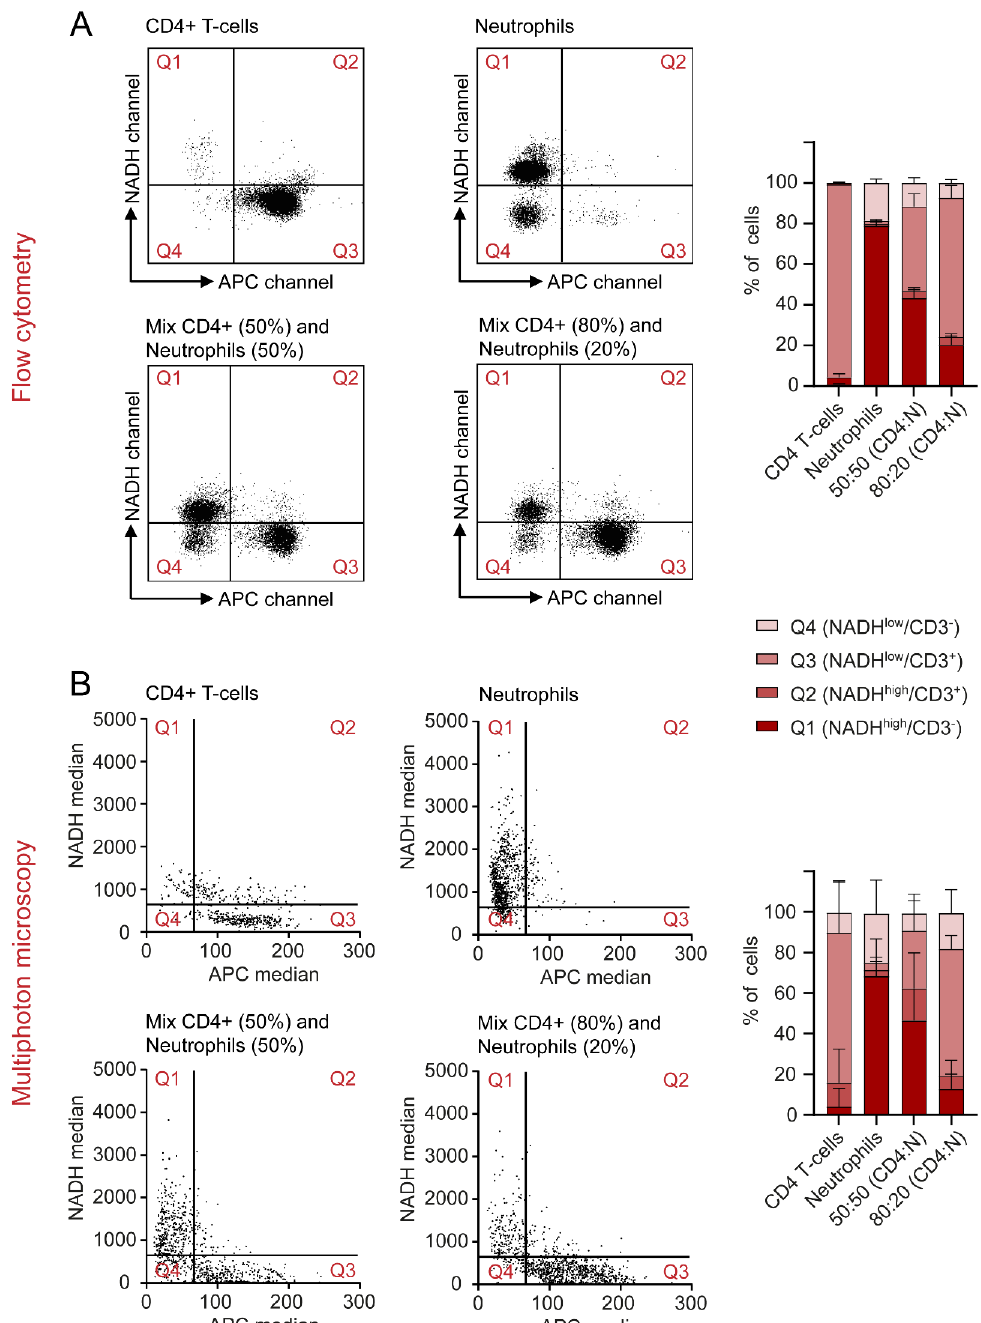
Figure 6. NADH autofluorescence signals may be used to differentiate between cell types in a mixed sample in flow cytometry and multiphoton microscopy. ( A , B ) Cells were divided into four quadrants, defined by high and low NADH and APC values. CD4+ T cells and neutrophils were analysed on their own and in mixed samples and the percentages of cells found in each quadrant were represented for both flow cytometry and MPM.